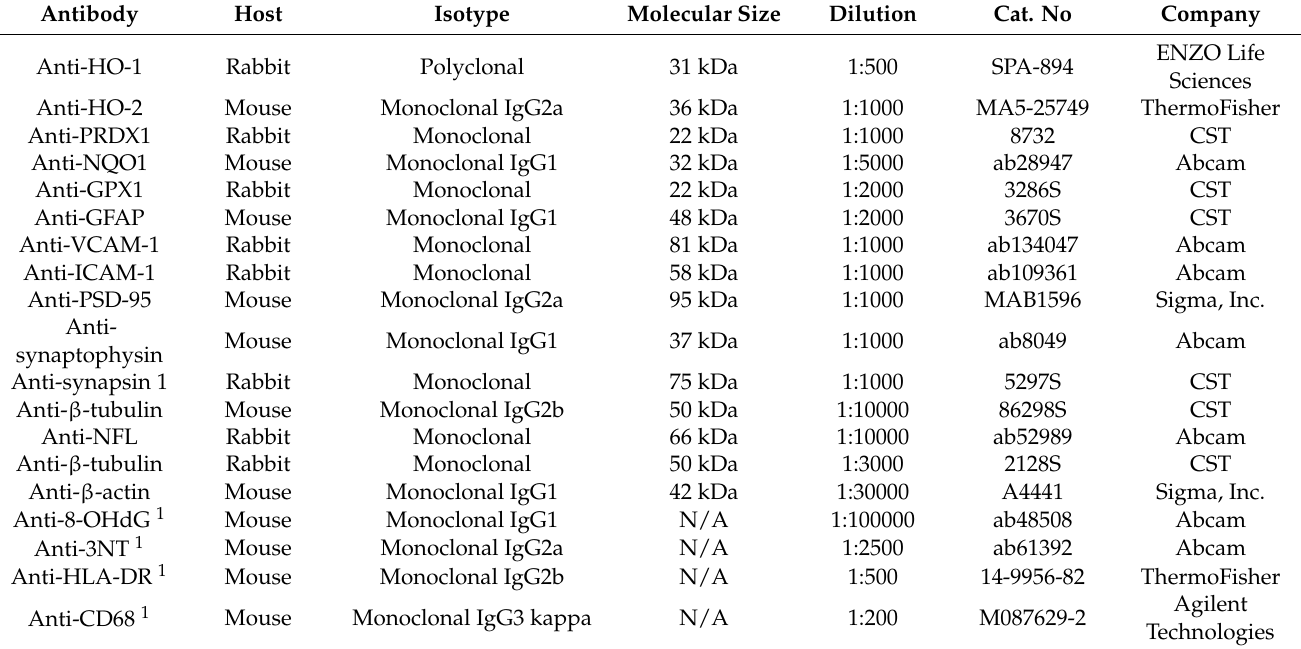
Table 1. Information regarding the antibodies used in the Western blotting and immunohistochemistry